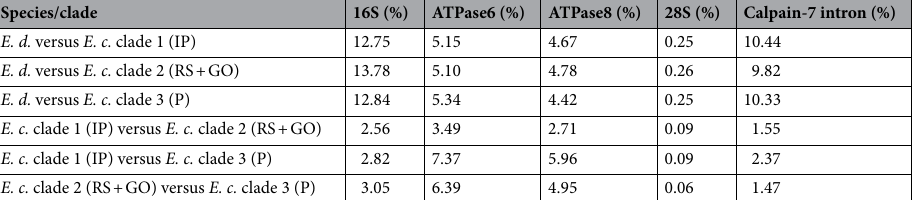
Table 1. Mean genetic difference between DNA sequences of Echinothrix diadema ( E. d. ) and clades of Echinothrix calamaris ( E. c. ) calculated using models suggested by jMODELTEST for each gene. See Fig. 1 for clade designations. RS Red Sea, GO Gulf of Oman, IP Indo-Pacific, P Pacific.